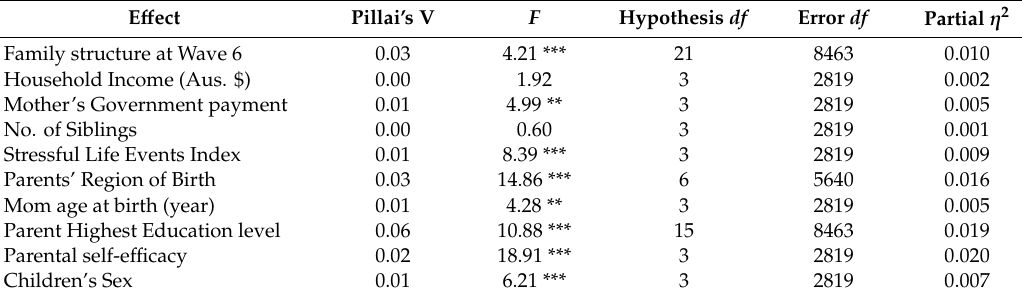
Table 4. MANCOVA results of parental involvement